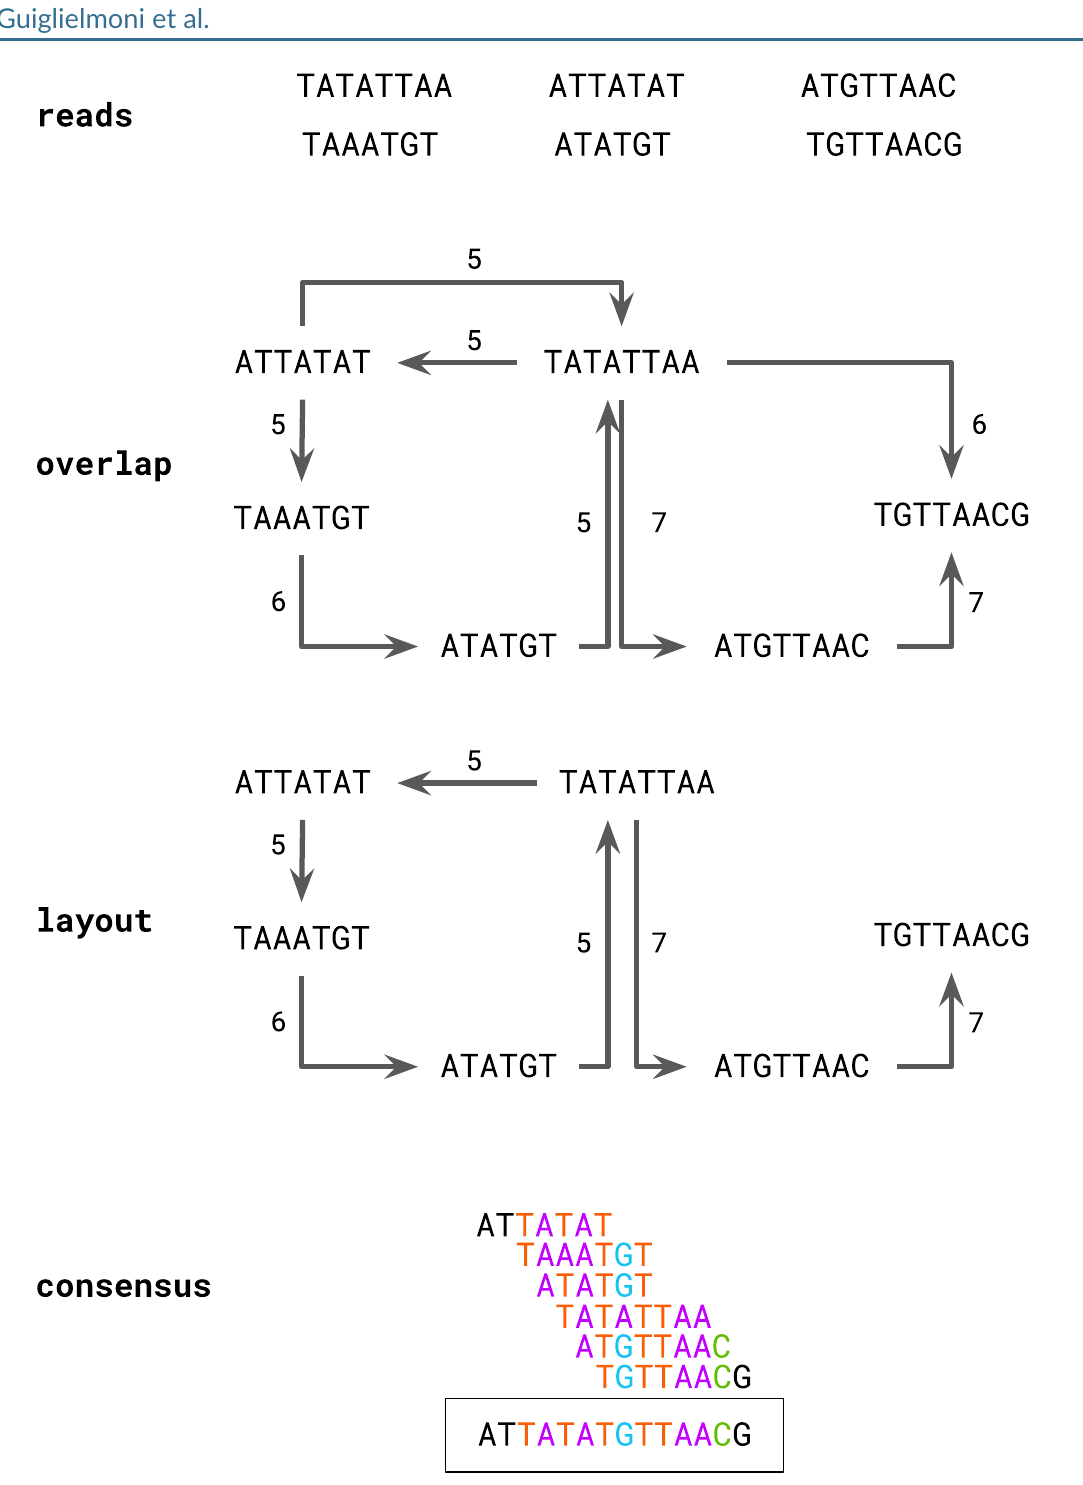
Figure 2 – Overview of Overlap-Layout-Consensus assembly. The graph was built with all overlaps of at least 5 bases with a tolerance of 1